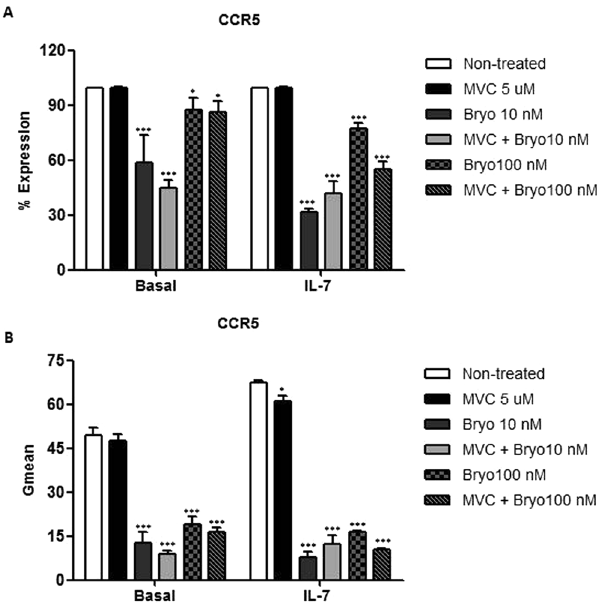
Figure 7. CCR5 expression levels on rCD4 cells treated with MVC or Bryostatin-1. rCD4 cells were treated with IL-7 for 10 days and then stained with a monoclonal antibody against CCR5 conjugated with PE. Non- treated cells were used as referred control. Signals corresponding to PE were analyzed by flow cytometry in FL2 channel. ( A ) The percentage of cells expressing CCR5 on the cell surface and ( B ) the geometric mean fluorescence intensity are represented after subtracting the isotope control. Statistical significance was calculated using two way ANOVA with Bonferroni post-test analysis ( * p < 0.05, ** p < 0.01 and and *** p < 0.001). Data shown are mean ± SEM from four independent